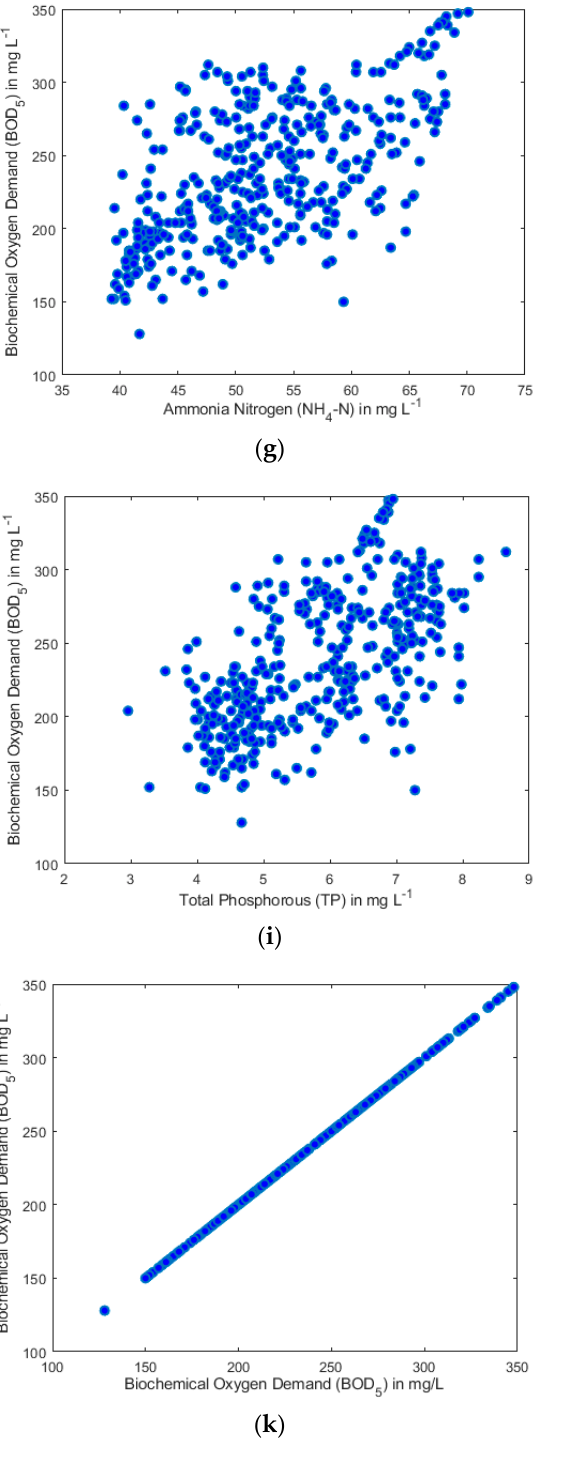
Figure 3. Scatter plots and histograms of the studied input and output parameters: ( a , b ) COD; ( c , d ) SS; ( e , f ) TN; ( g , h ) NH 4 -N; ( i , j ) TP; and ( k , l ) BOD 5 .